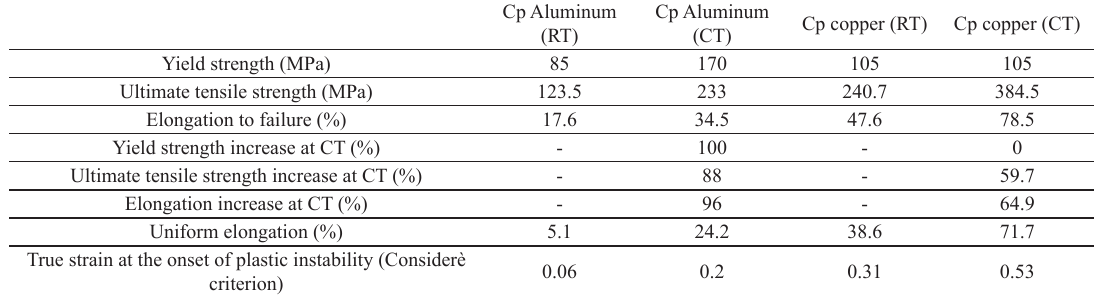
Table 2. Comparison between tensile tests at RT and CT for aluminum and copper.